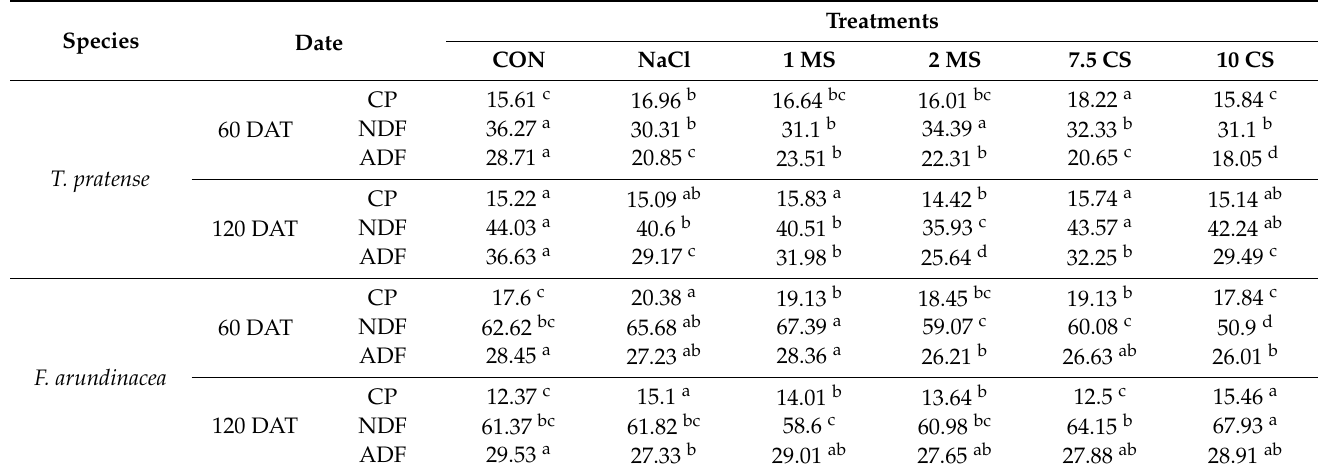
Table 2. Crop quality indicators